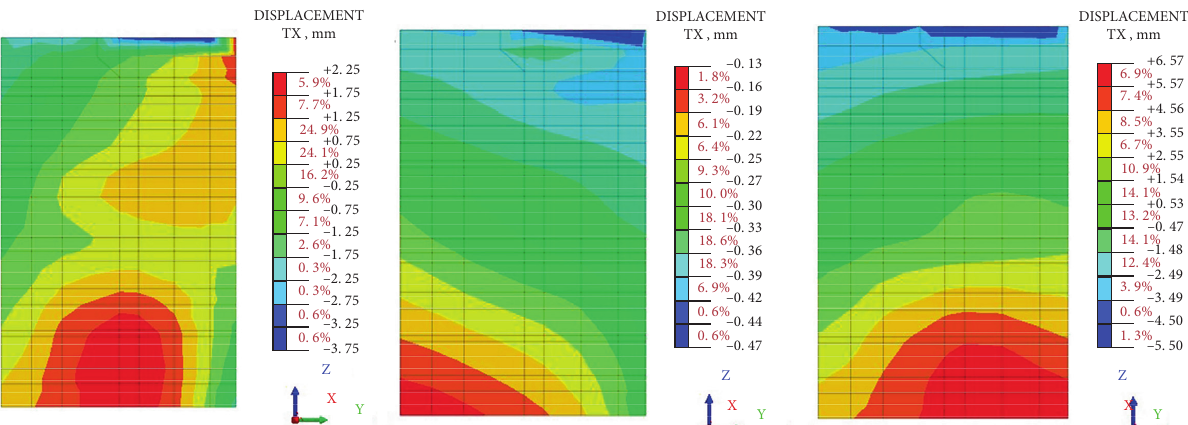
Figure 8: Horizontal displacement of the common ground wall in the north-south direction when the foundation pit in area B was excavated to the pit